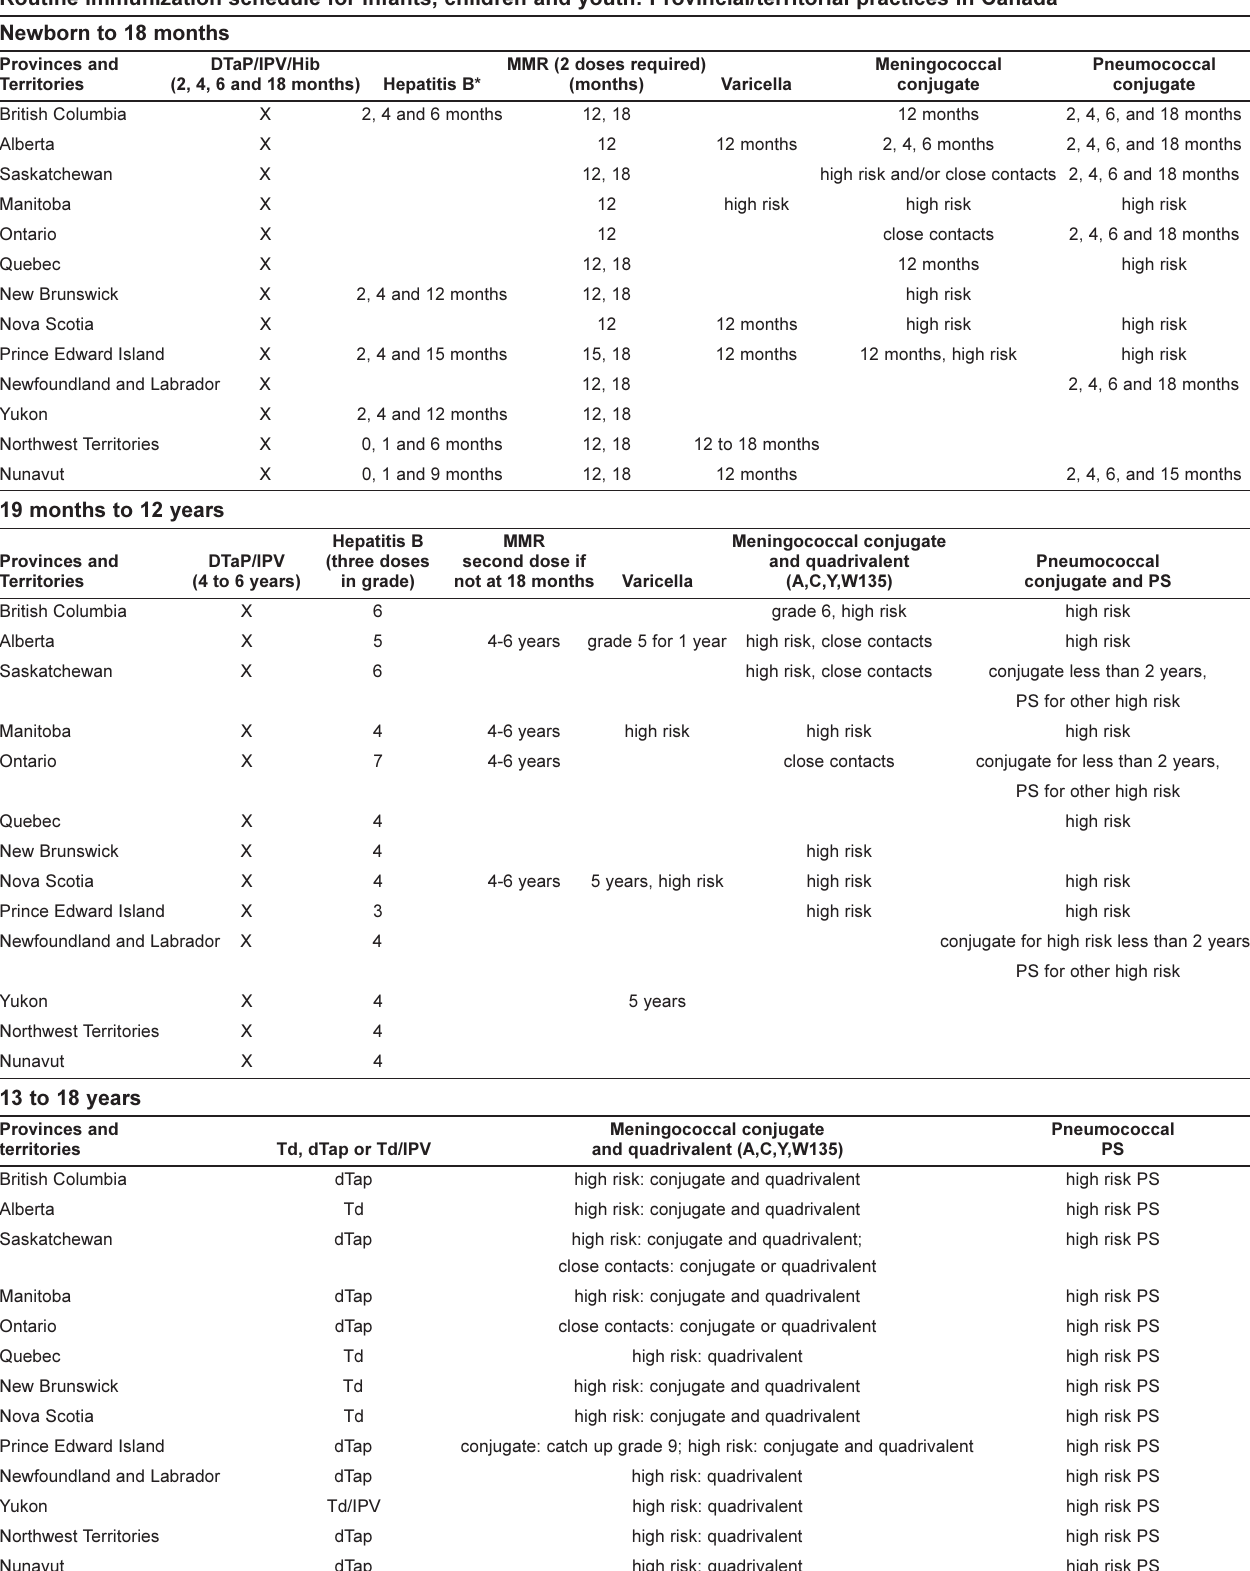
TABLE 2 Routine immunization schedule for infants, children and youth: Provincial/territorial practices in Canada Newborn to 18 months Provinces